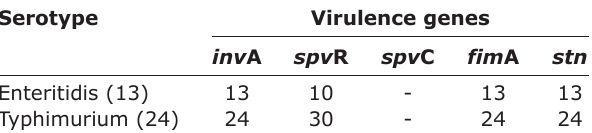
Table-3: Virulence genes present in different serovars of Salmonella . Serotype